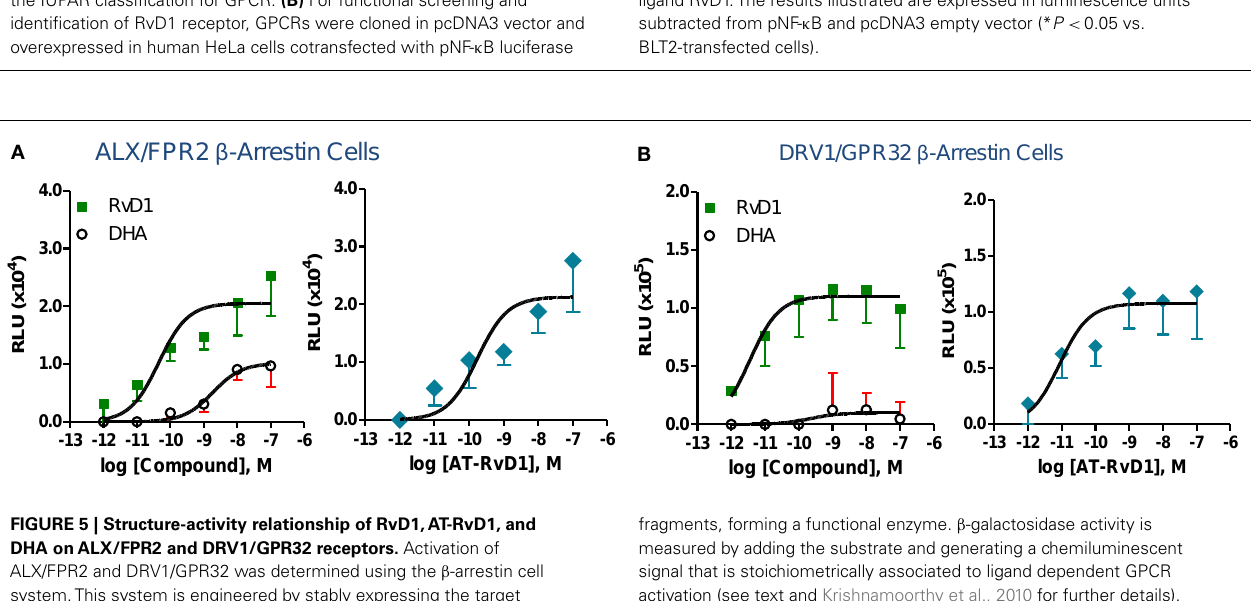
FIGURE 5 | Structure-activity relationship of RvD1,AT-RvD1, and DHA onALX/FPR2 and DRV1/GPR32 receptors. Activation of ALX/FPR2 and DRV1/GPR32 was determined using the β -arrestin cell system.This system is engineered by stably expressing the target ALX/FPR2 or DRV1/GPR32 tagged with the β -galactosidase Pro-Link peptide. Cells also co-expressed the β -arrestin protein linked to the β -galactosidase EA fragment. In the presence of ligand, activated GPCR interacts with β -arrestin, bringing to proximity the EA and Pro-Link